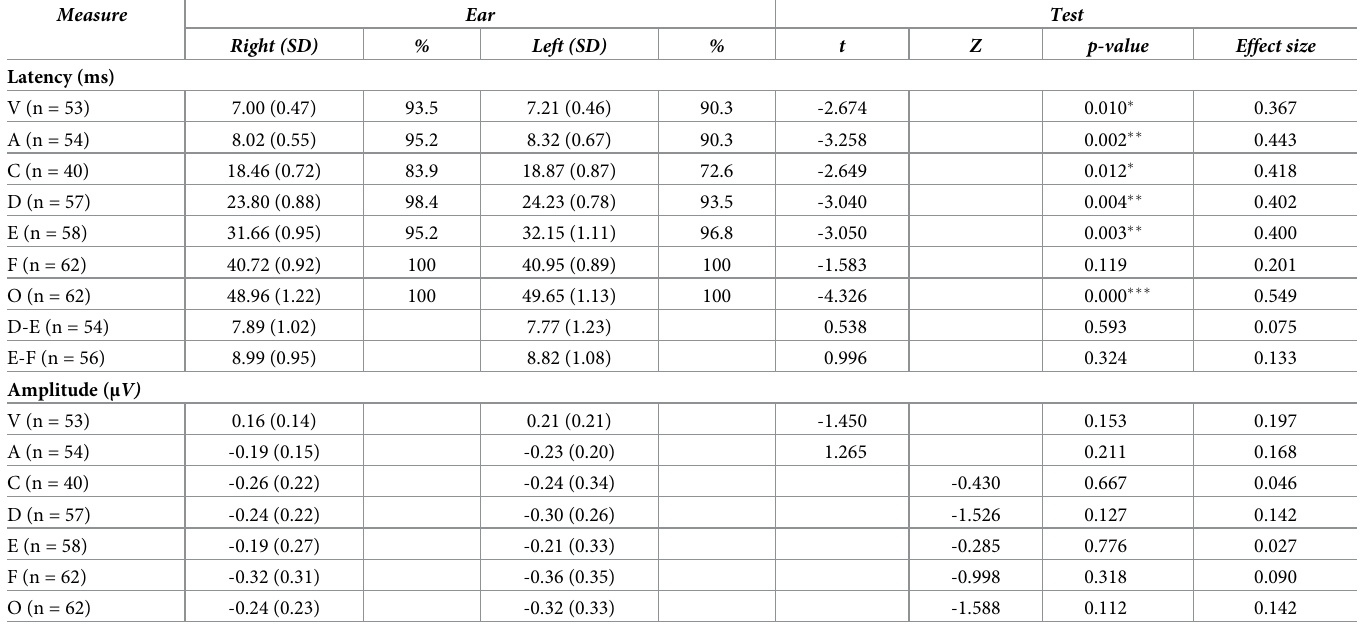
Table 2. Mean and standard deviation of latency (after stimulus onset) and amplitude values of the speech-ABR components for the right and left ears for the group of participants. Measure Ear Test Right (SD) % Left (SD) % t Z p-value Effect size